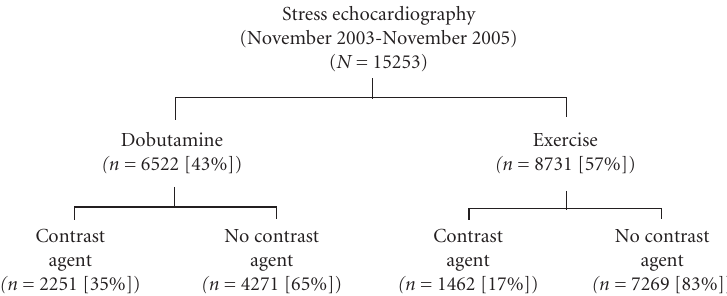
Figure 2: Flowchart of patients included in analyses.